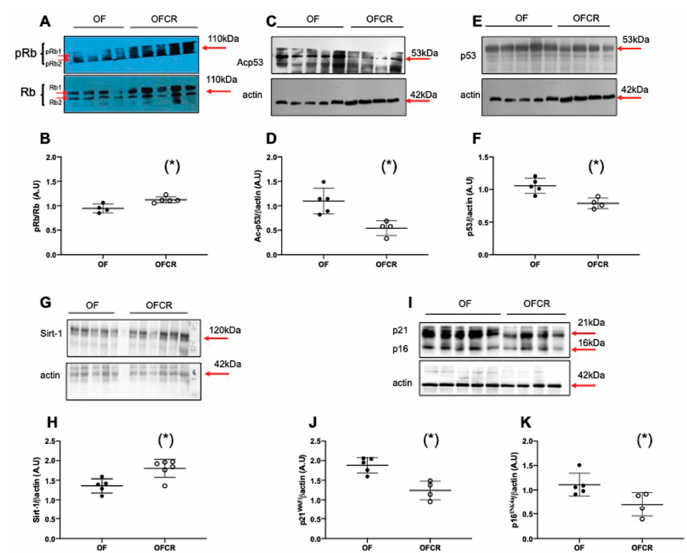
Figure 5. Hepatic senescence in the animals in the OF and OFCR groups at seven months. Liver protein levels of pRb / Rb ( A , B ), Ac-p53 ( C , D ), p53 ( E , F ), Sirt-1 ( G , H ), p21 WAF ( I , J ) and p16 INK4a ( I , K ) were measured by western blot in the OF and OFCR groups. Values are reported as the mean ± SD; (*) p < 0.05; n = 5–4 or 6 animals / group. Nutrients 2019 , 11 , x FOR PEER REVIEW